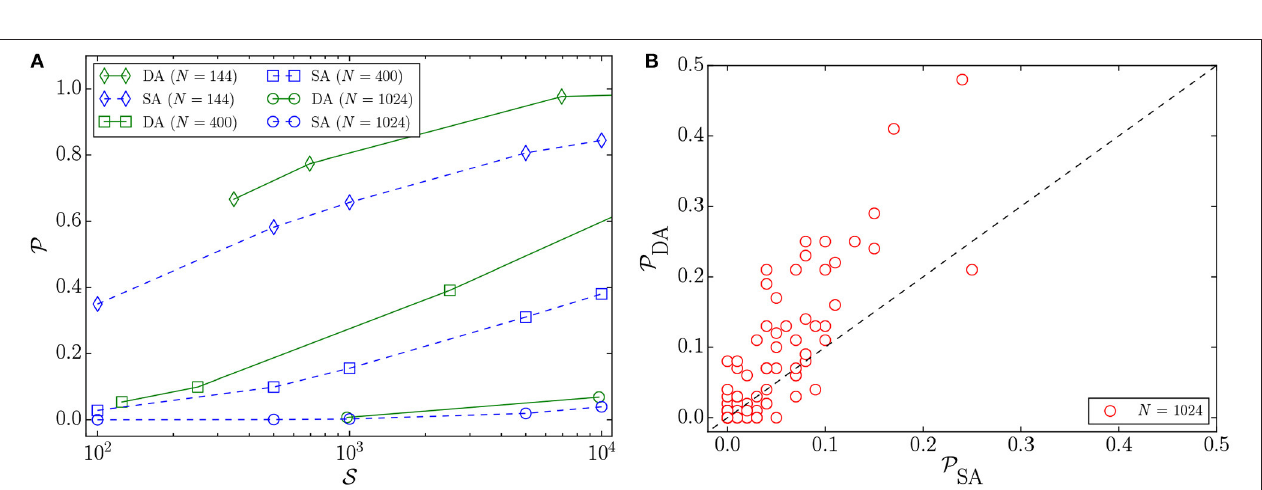
FIGURE 4 | (A) Mean success probabilities ( P ) of 2D-bimodal instances vs. the number of Monte Carlo sweeps ( S ) for different problem sizes N solved by the DA and SA. The error bars are not included, for better visibility. (B) Success probability correlation plot of 100 2D-bimodal instances with N = 1,024 variables, where the number of sweeps is 10 4 for SA and the number of iterations is 10 7 for the DA. Because each sweep corresponds to N = 1,024 iterations, the number of sweeps is ≃ 10 4 for the DA, as well.